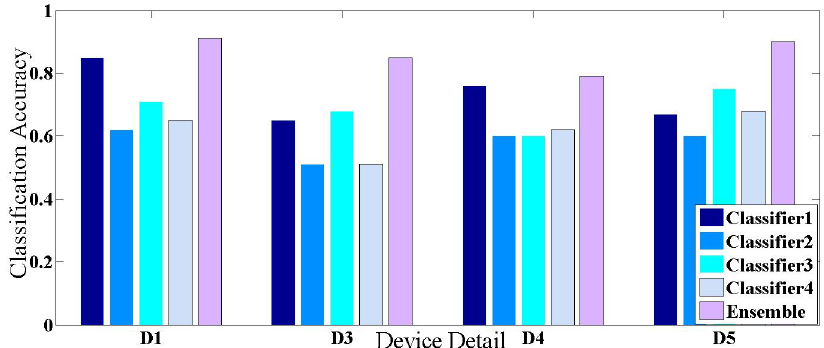
Figure 9. Classification accuracy for device and position independent activity recognition: Test devices (D1, D3, D4 and D5) kept in SPT.